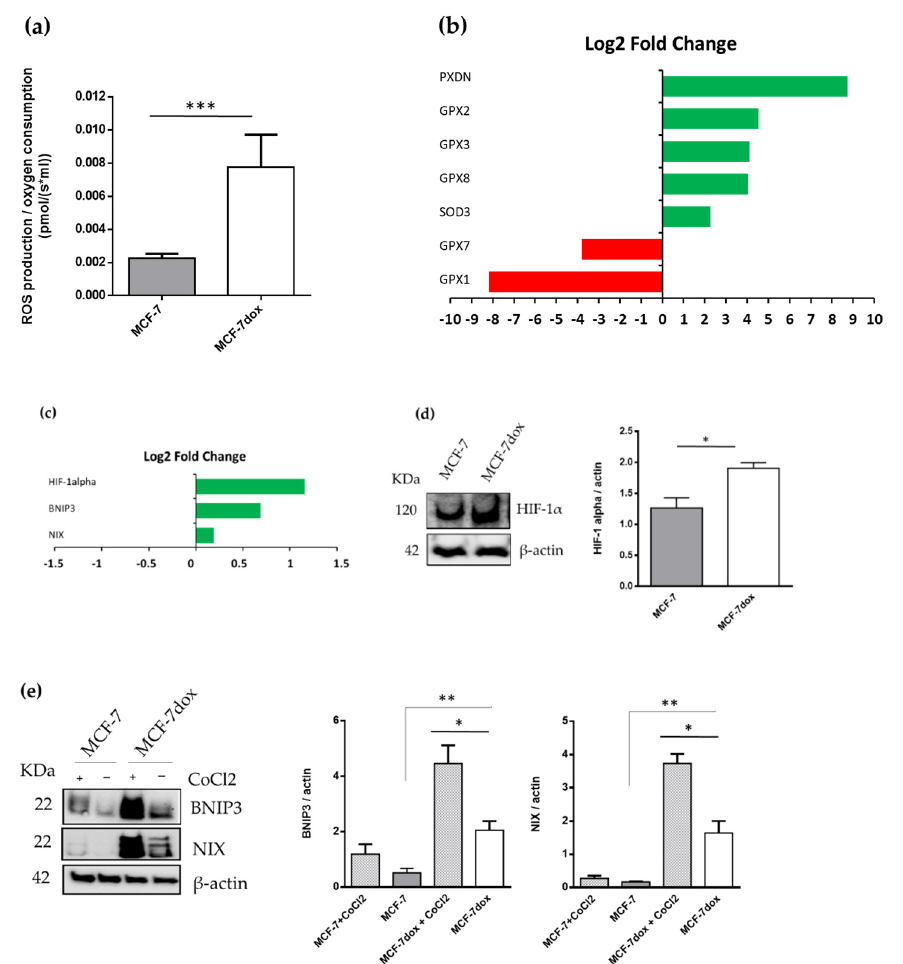
Figure 2. Mitochondrial ROS production is increased and is associated with a higher expression of hypoxia-inducible factor-1 in DOX-resistant breast cancer cells. ( a ) Mitochondrial ROS production was evaluated simultaneously with mitochondrial oxygen consumption by measuring the hydrogen peroxide-induced fluorescence of Amplex Red. Mitochondrial oxygen consumption was measured by high-resolution respirometry. Experiment was carried out in the presence of glutamate, malate, and ADP ( n = 7); ( b , c ) gene expression analysis. Results are represented as Log2 Fold Change